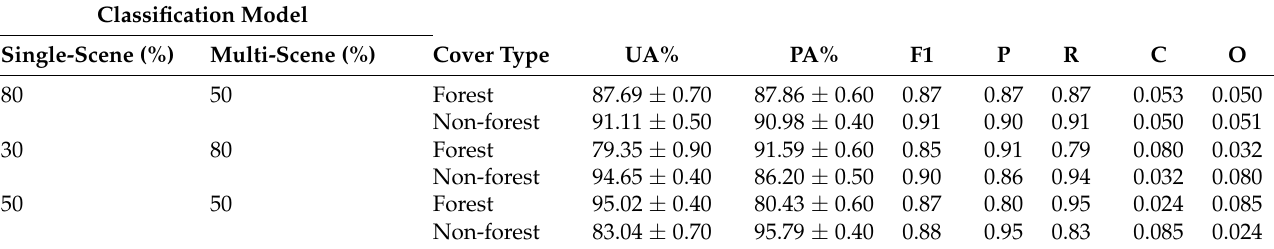
Table 4. Detailed accuracy metrics for the best three classification models. Classification Model